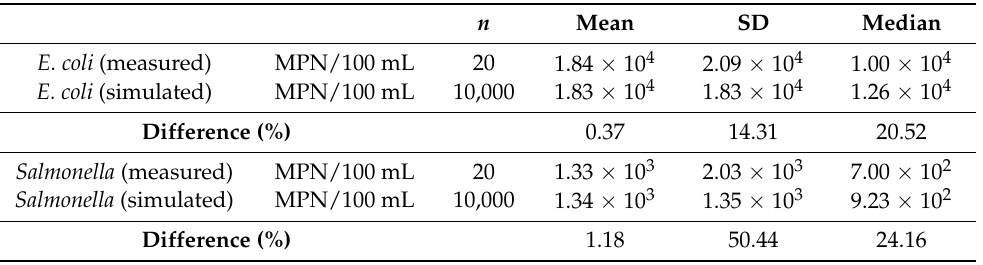
Table 2. Differences between simulated (10,000 times) and observed (20 samples) E. coli and Salmonella